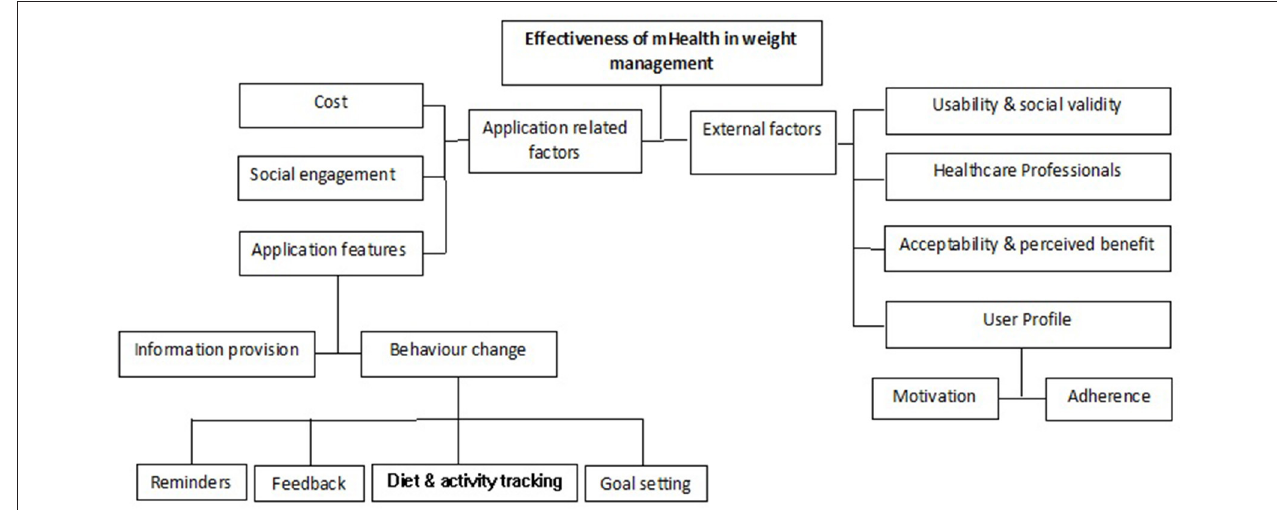
FIGURE 1 | Factors influencing the effectiveness of mHealth in weight